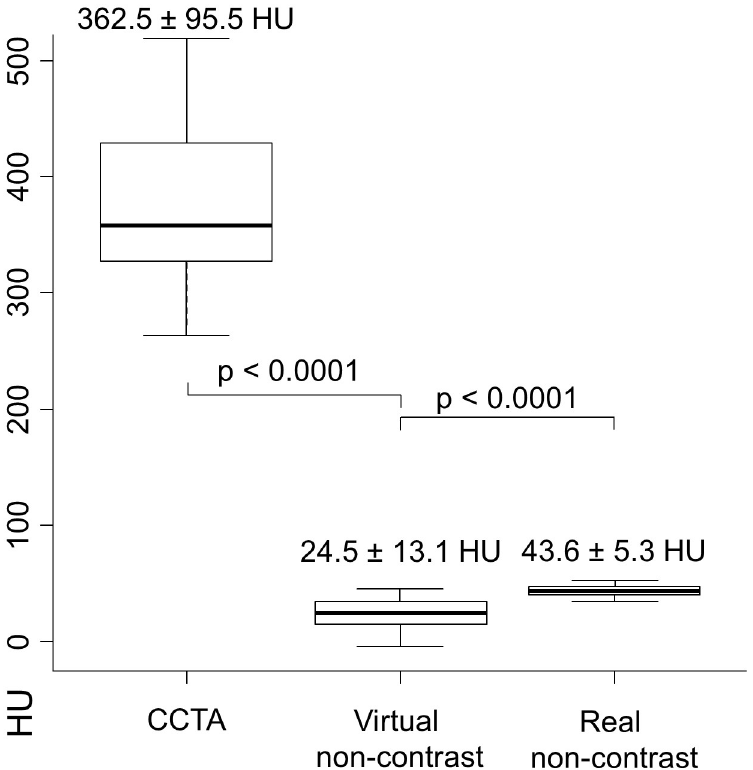
Fig 3. Hounsfield units in the ascending aorta. Boxplots illustrating the statistically significant reduction of HU values in the ascending aorta with the applied virtual non-contrast algorithm measured in axial slices as shown in Fig 1. The mean density in the aorta in the virtual non-contrast images was statistically significantly lower compared to the real non-contrast images. CCTA = Coronary Computed Tomography Angiography.